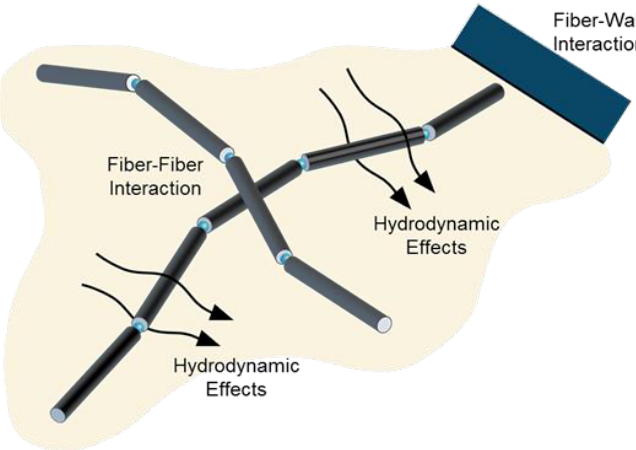
Figure 3. Mechanistic model approach with fibers displayed as beam elements inside the polymer flow [6] .